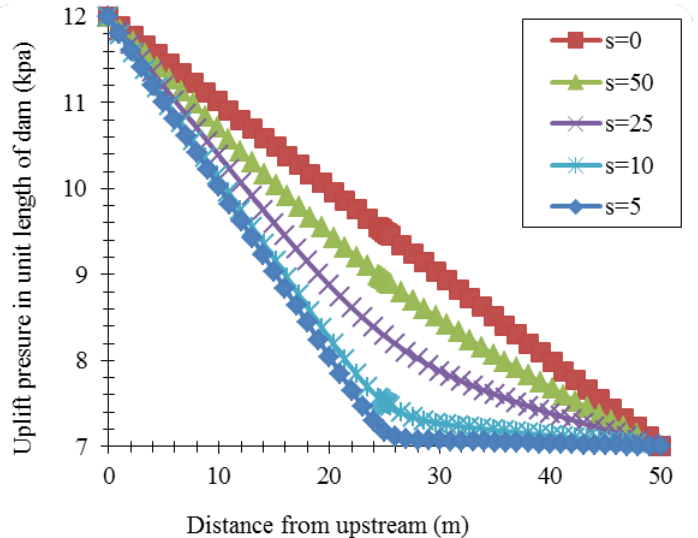
Fig. 5. Effect of wells distances ( S ) with 0.5 m in diameter, on uplift